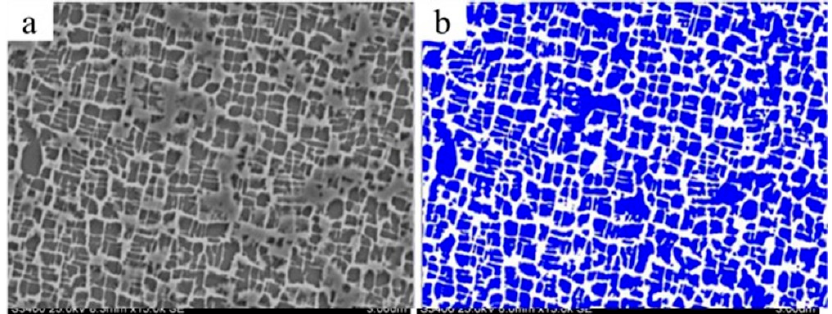
Figure 4. An example of image processing (binarization) to determine the volume fraction of microstructure constituents: ( a ) initial greyscale image (for microstructure of casting withdrawn at the rate of 1 mm/min), ( b ) binary image.